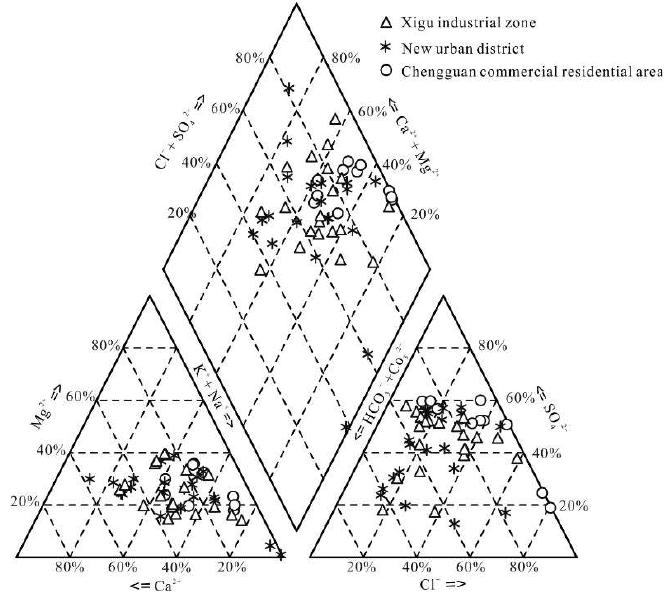
Figure 5. Piper plots of the groundwater chemistry in various urban functional areas.